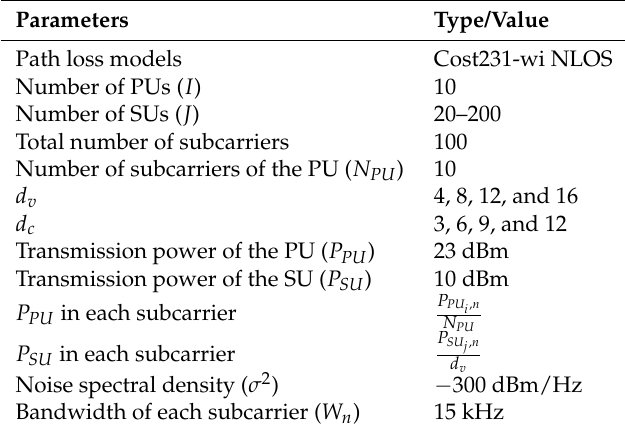
Table 3. Simulation